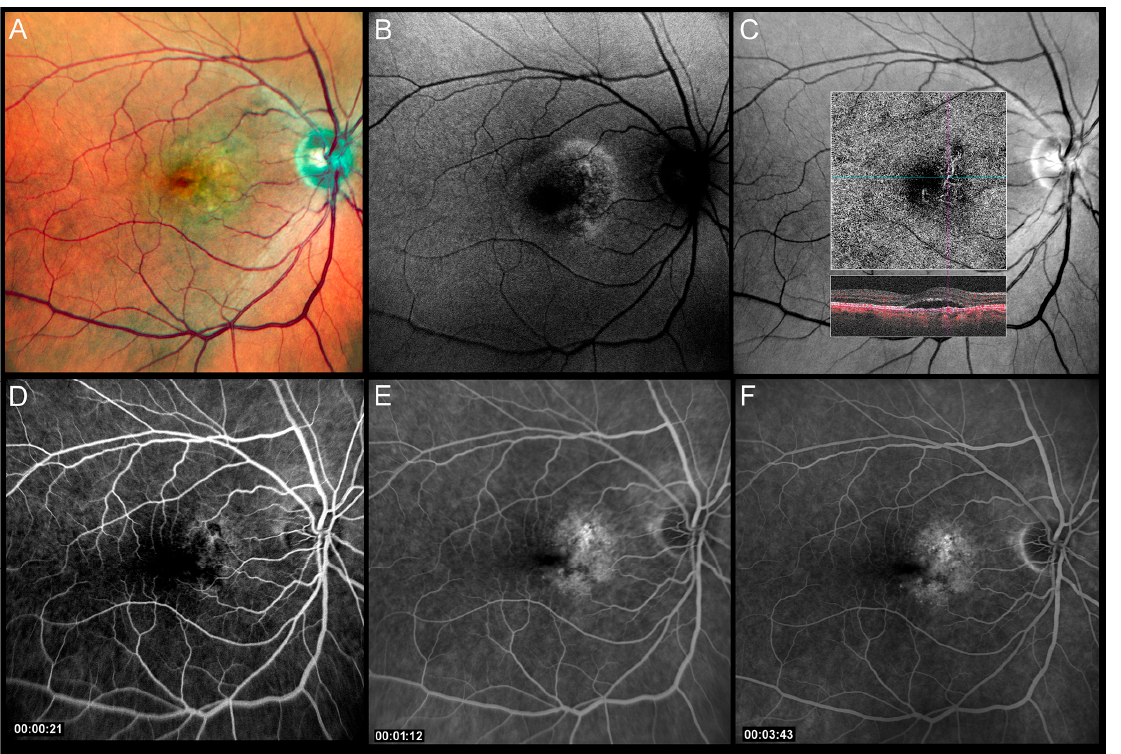
Figure 1. Preoperative multimodal imaging of patient 1: ( A ) Pseudocolor image shows pigmentary changes and thickening in the nasal part of the macula; ( B ) autofluorescence image, note the lobulated area with a pattern of speckled autofluorescence centrally and hyperautofluorescent borders; ( C ) green channel image with superimposed en face optical coherence tomography angiography and OCT B-scan showing the choroidal neovascularization; ( D – F ) progressive phases of the fluorescein angiogram which show slow dye diffusion confirming the presence of active macular